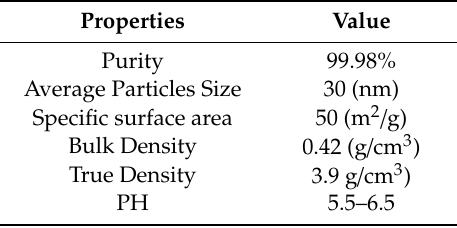
Figure 3. Size distribution of the natural aggregate and EGA.